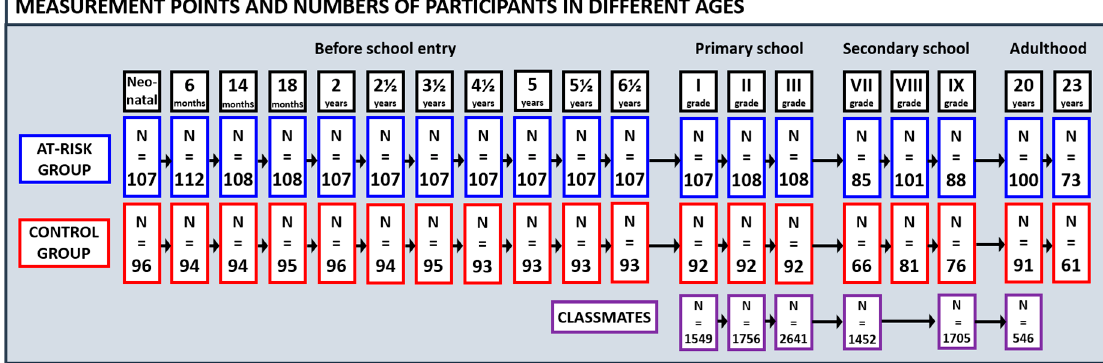
Figure 1. Screening of the families for the Jyväskylä Longitudinal Study of Dyslexia. To be included in the FR group, at least one parent of the child had to perform poorly